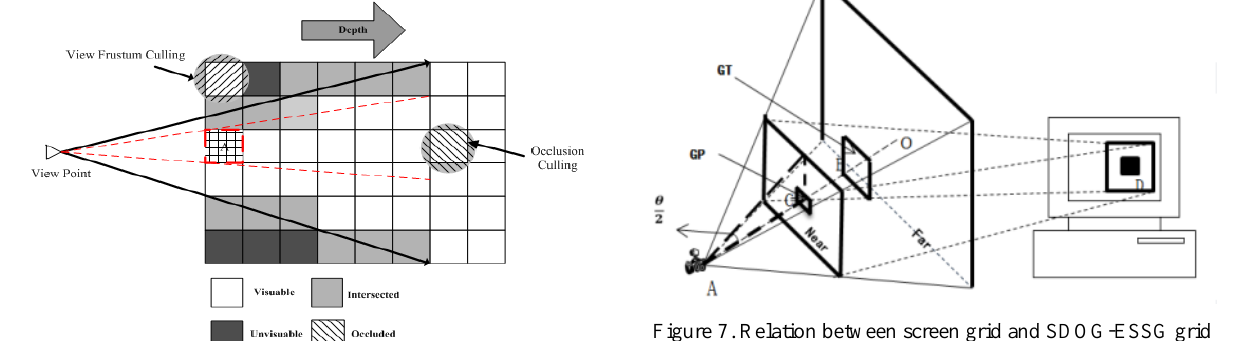
Figure 7. Relation between screen grid and SDOG-ESSG